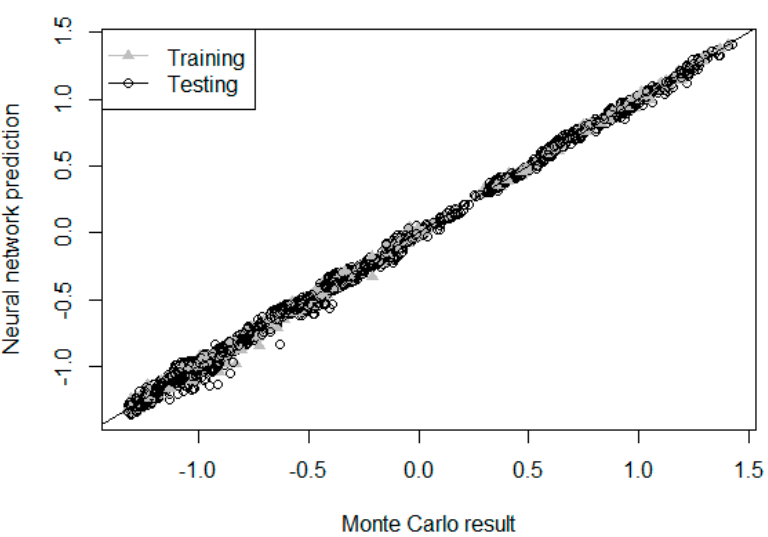
Figure 3. Scatterplot of the results of using a neural network to approximate the MC pricing methodology for the guaranteed minimum death benefit (GMDB). For this guarantee, the neural network (NN) achieves an R 2 better than 0.997.